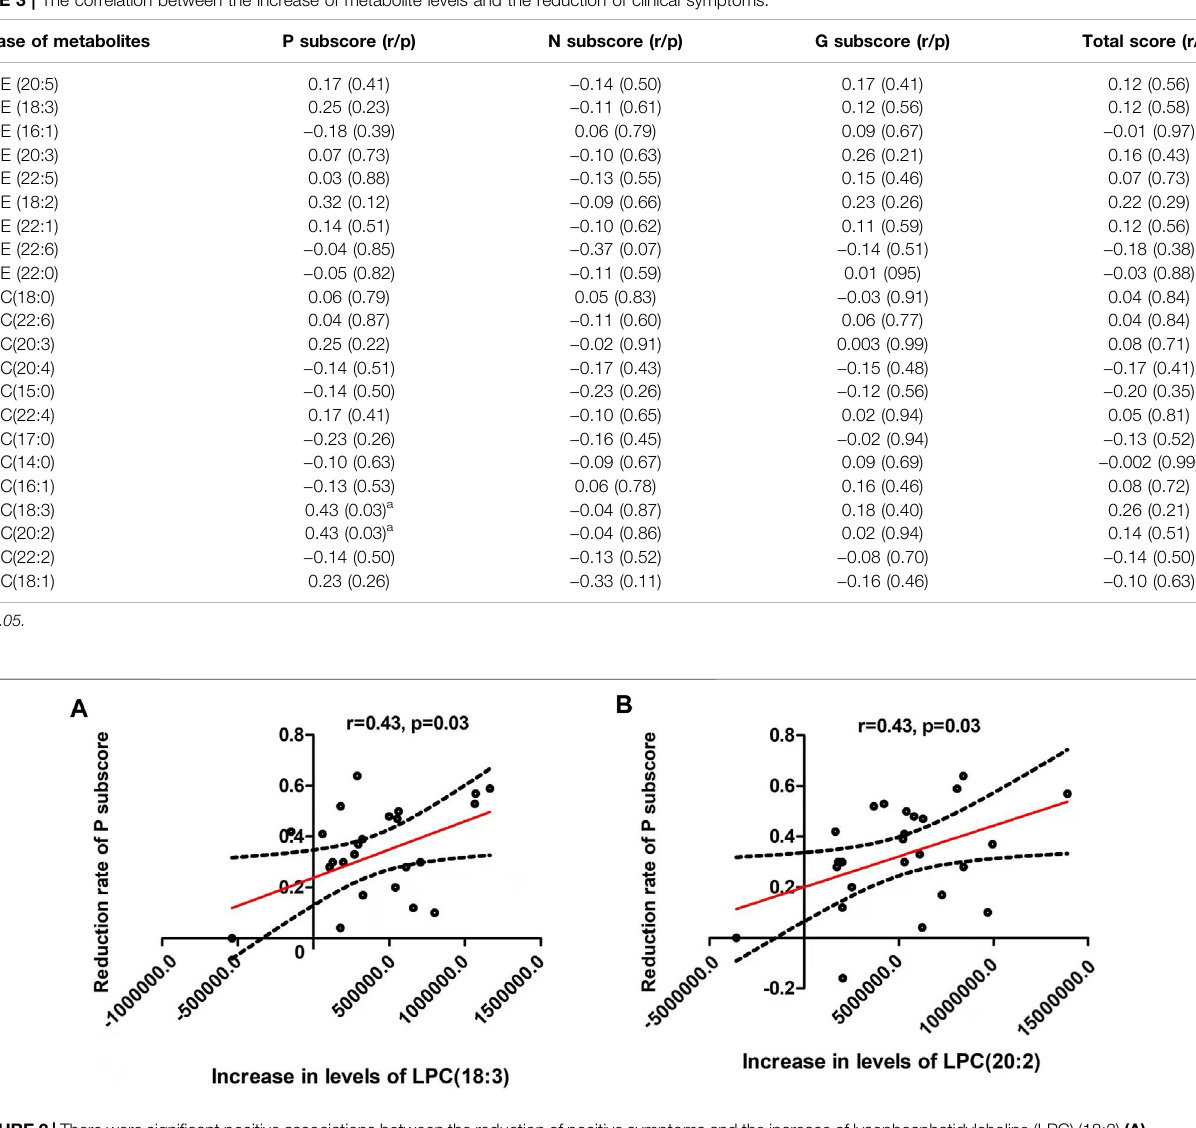
Frontiers in Pharmacology |